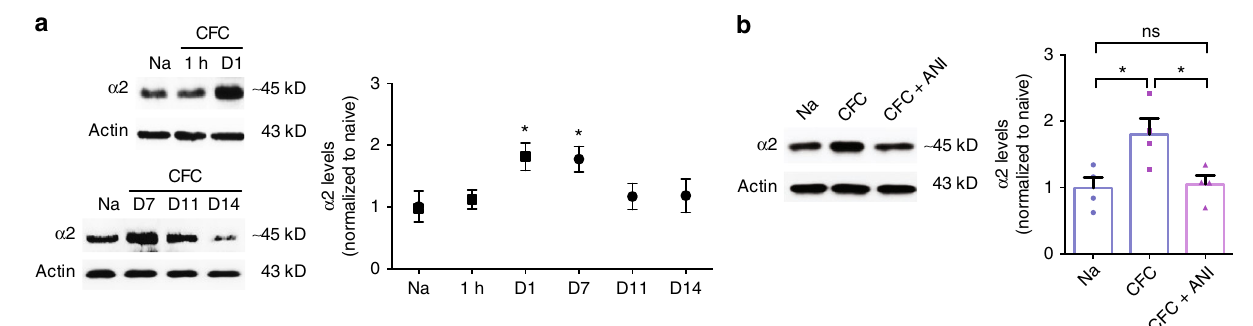
Fig. 3 Learning-evoked the synthesis of Rac-GAP α 2-chimaerin. a Representative image of western blottings (left) and data (right) showing hippocampal α 2-chimaerin of Na mice and CFC mice. * P < 0.05 (from one-way ANOVA); n = 12, 4, 6, 5, 6, 5 mice. b Immunoblotting exhibiting hippocampal α 2- chimaerin of Na mice, CFC mice, and CFC mice with ANI treatment (CFC + ANI) mice at 1 day after training. * P < 0.05 (from one-way ANOVA); n = 4, 4, 4 mice. Data are presented as means ± SEM. Also see Supplementary Table